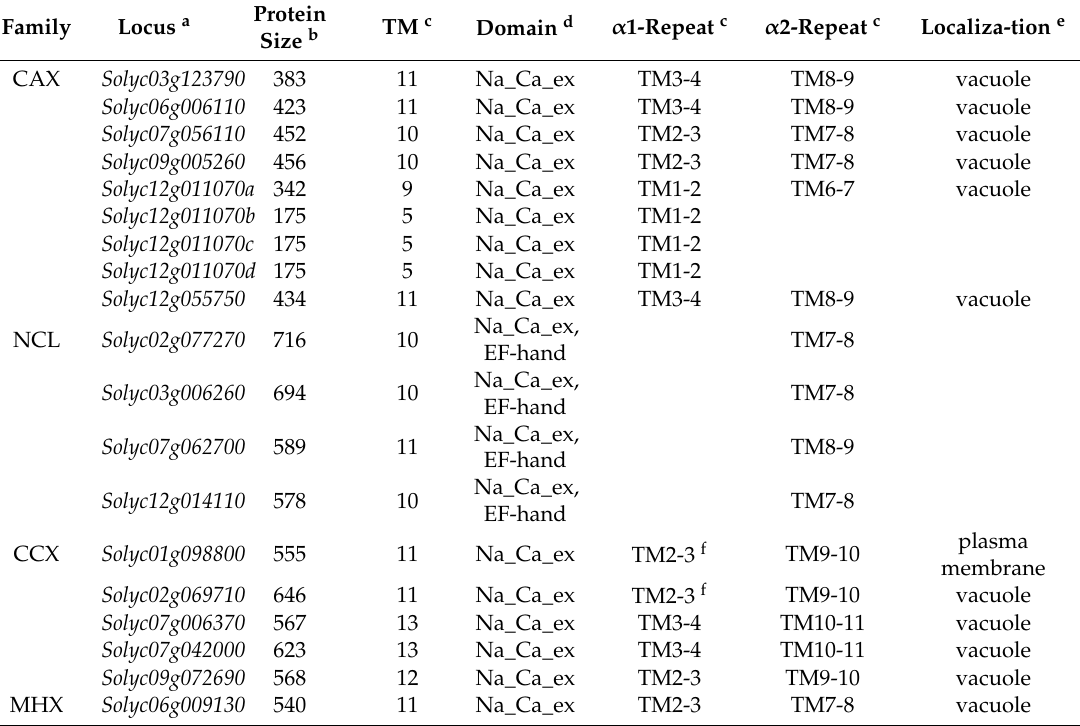
Table 1. Characteristic features of tomato CaCA superfamily